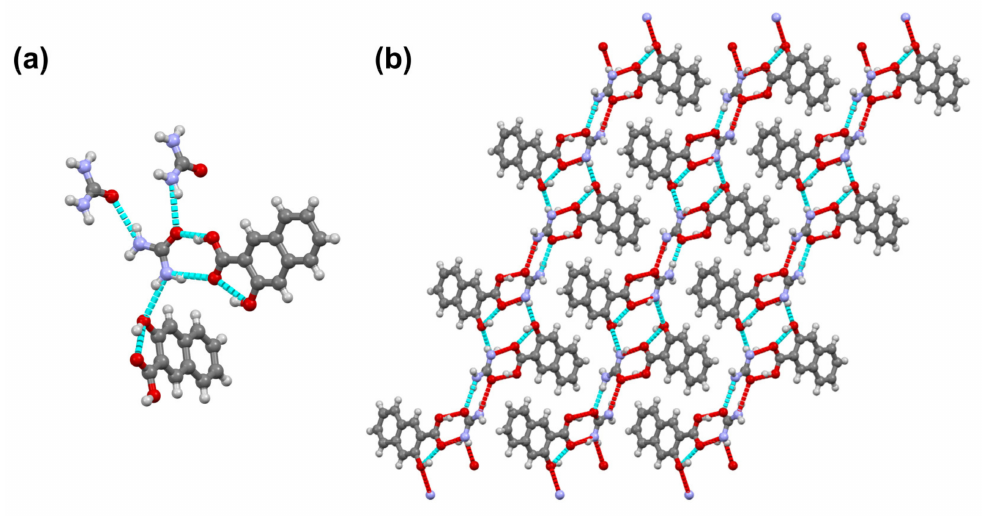
Urea and 3-hydroxyl-2-naphthoic acid crystallize in the monoclinic C 2/ c space group in a 1:1 ratio. The carboxylic acid of 3-hydroxyl-2naphthoic acid, is connected to the amide group of urea through an amide-acid hetero-synthon. The phenyl hydroxyl forms an intramolecular hydrogen bond, as well as an intermolecular hydrogen bond with urea (Figure 5). Other hydrogen bonding patterns involve different urea molecules and are of the C = O–H–N type (Figure 5).